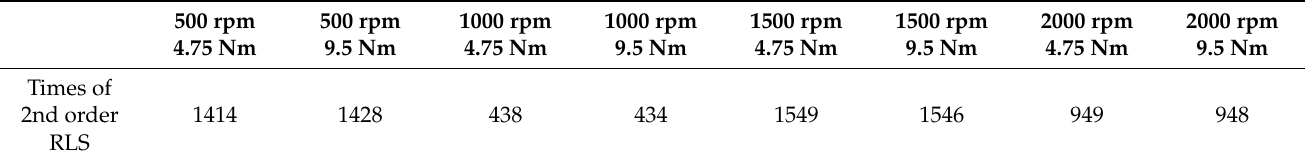
Table 4. Required RLS iteration times by using initial L d 0 .